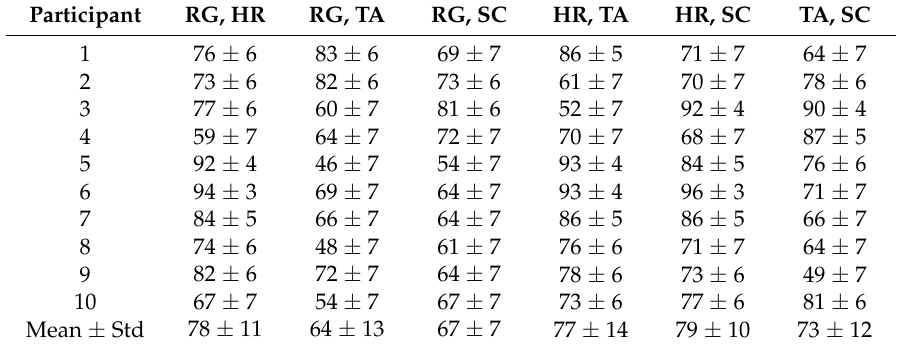
Table 3. Probability of successful detection of stress level using two stress markers as